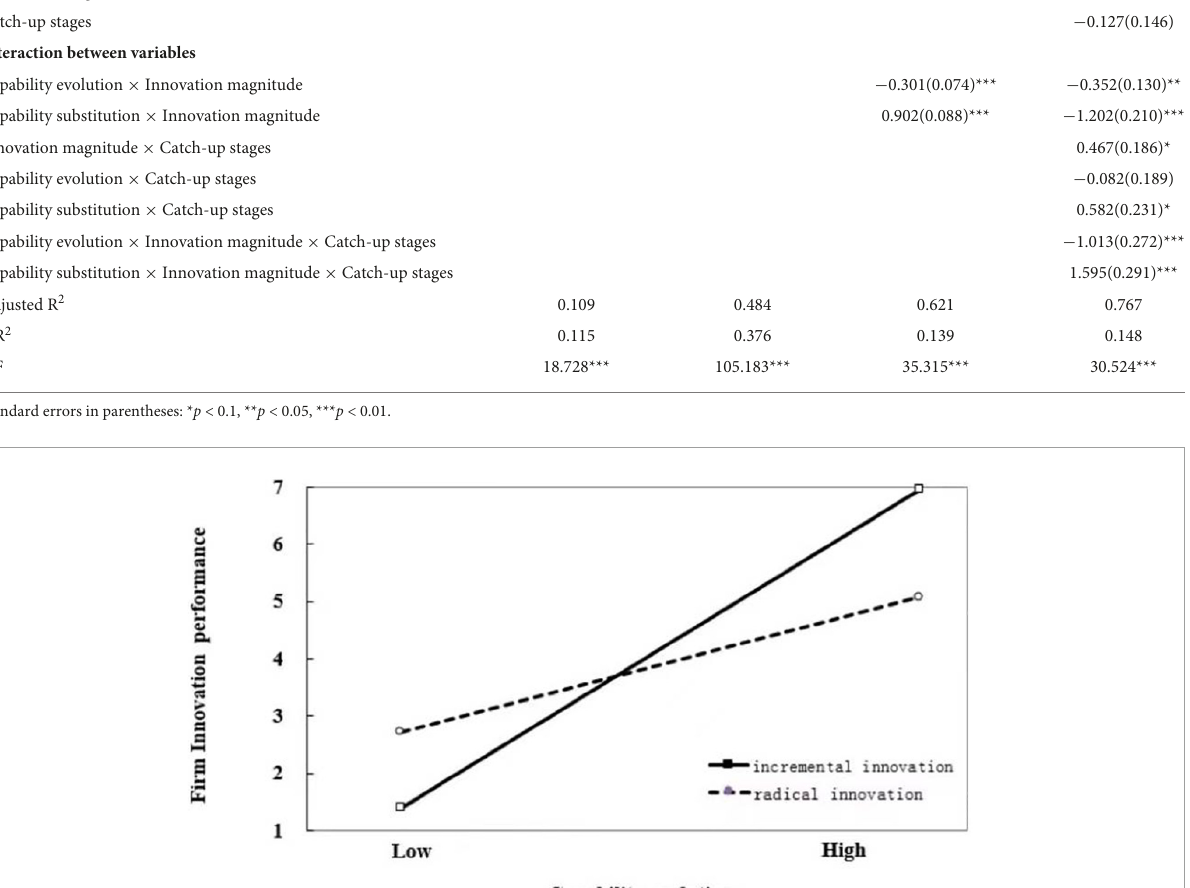
innovation and enhance competitiveness (Chen et al.,